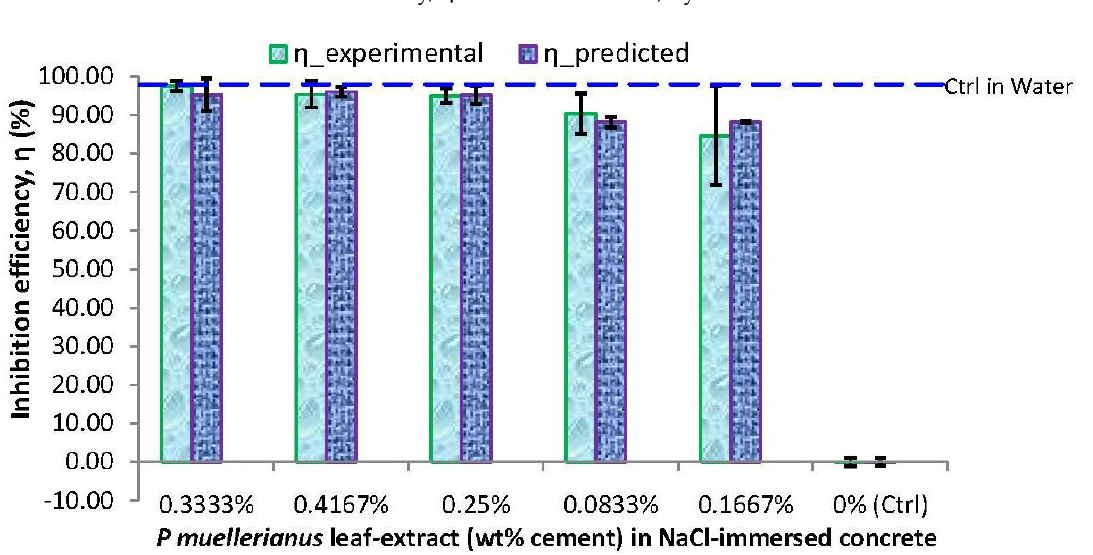
Figure 4. Ranking order of Inhibition efficiency performance by P. muellerianus leaf-extract.